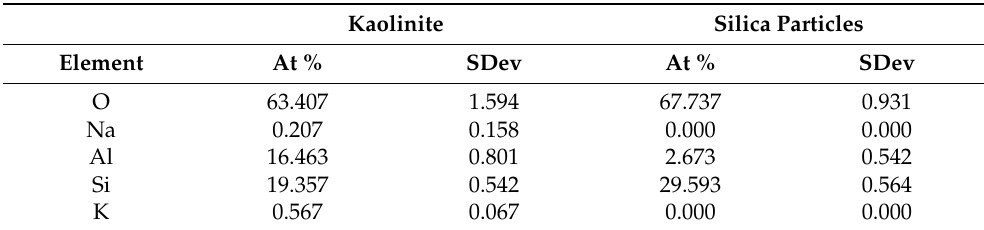
Table 1. EDX analysis of kaolinite and silica particles. The average of three measurements are reported. Kaolinite Silica Particles Element At